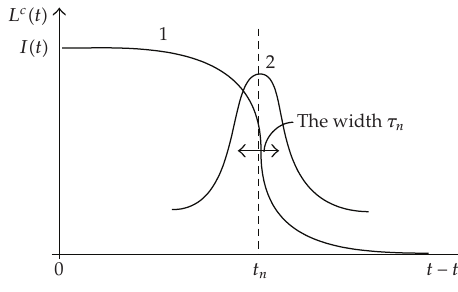
Figure 15: L c (cid:2) t (cid:3) (cid:2) curve 1 (cid:3) and I (cid:2) t (cid:3) (cid:2) curve 2 (cid:3)